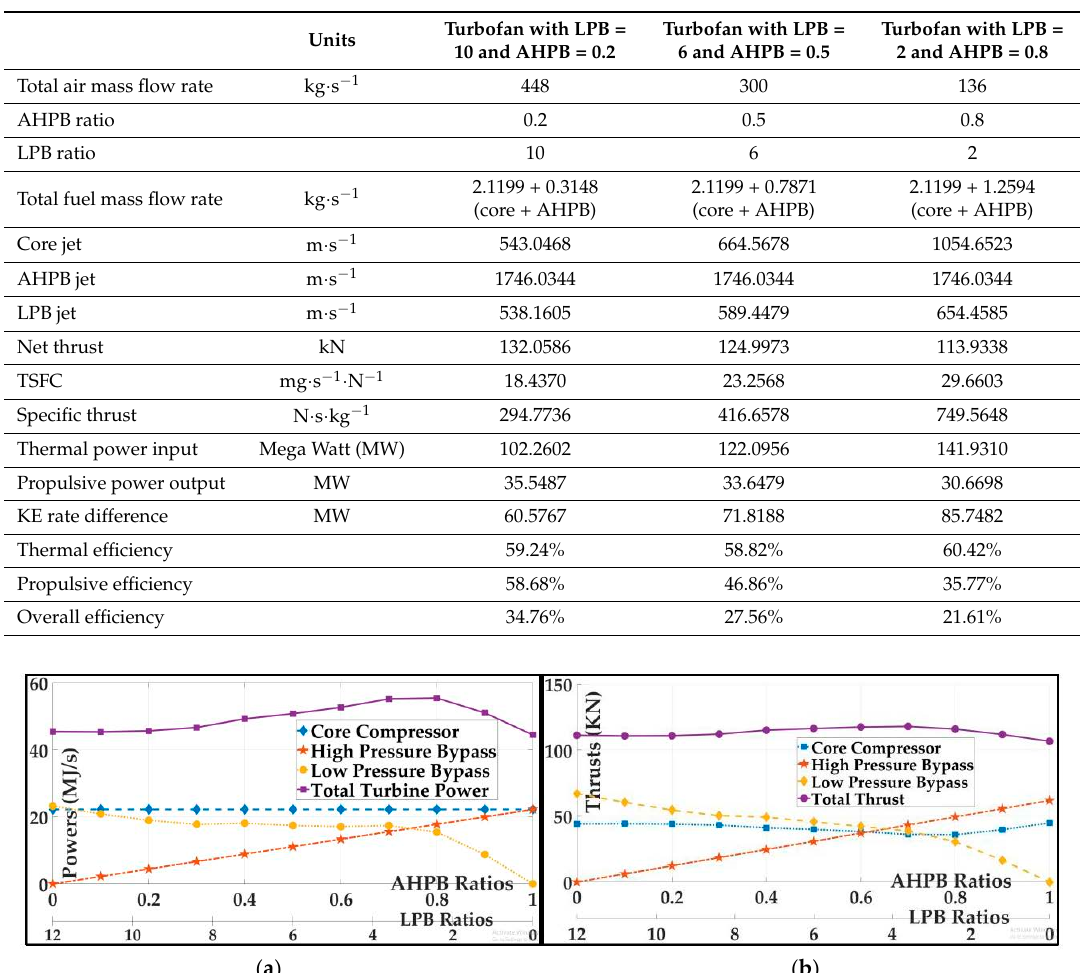
Table 2. Performance parameters for select turbofan engines with an auxiliary high-pressure bypass (AHPB). LPB—low-pressure bypass.; TSFC—thrust-specific fuel consumption; KE—kinetic energy.